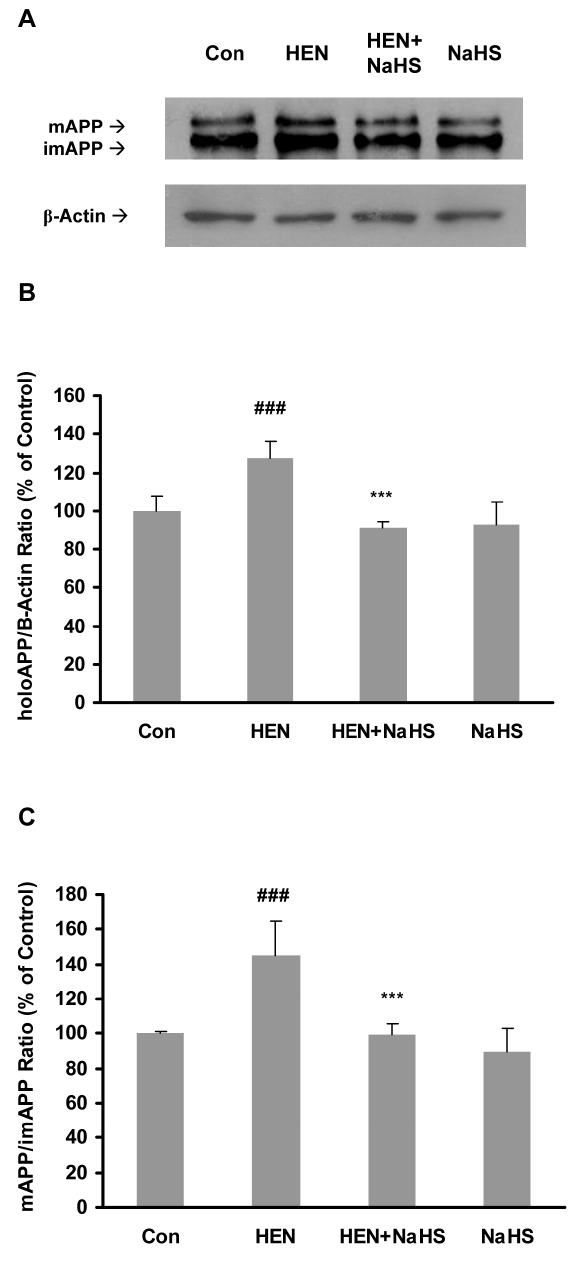
Figure 6. Effect of NaHS on production and maturation of APP. Representative gel (A) and quantitative analysis (B–C) showing the effects of NaHS (100 m M, 12 hours) on HENECA (100 nM, 24 hours) stimulated production (B) and maturation (C) of APP. The cell lysates were analysed by western blot technique with antibody against N- terminus of APP or b -actin. The extent of maturation of APP is shown as the ratio between mAPP to imAPP. mAPP and imAPP are represented by upper and lower bands in a blot respectively. b -actin was used as a loading control. Data are given as means 6 S.E.M, n=4. ### p , 0.001 vs Con group; *** p , 0.001 vs HEN group. Con, control; HEN,